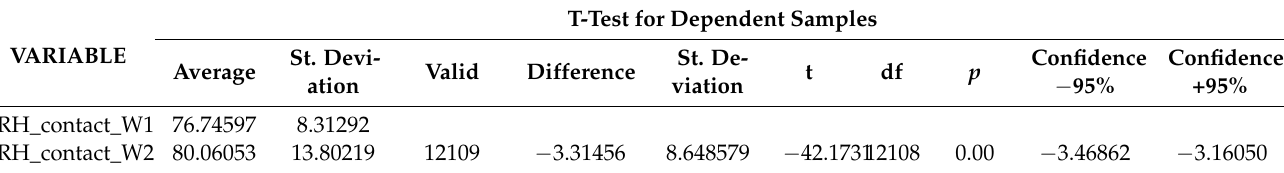
Table 5. Exemplary results for the compliance test in humidity distribution.